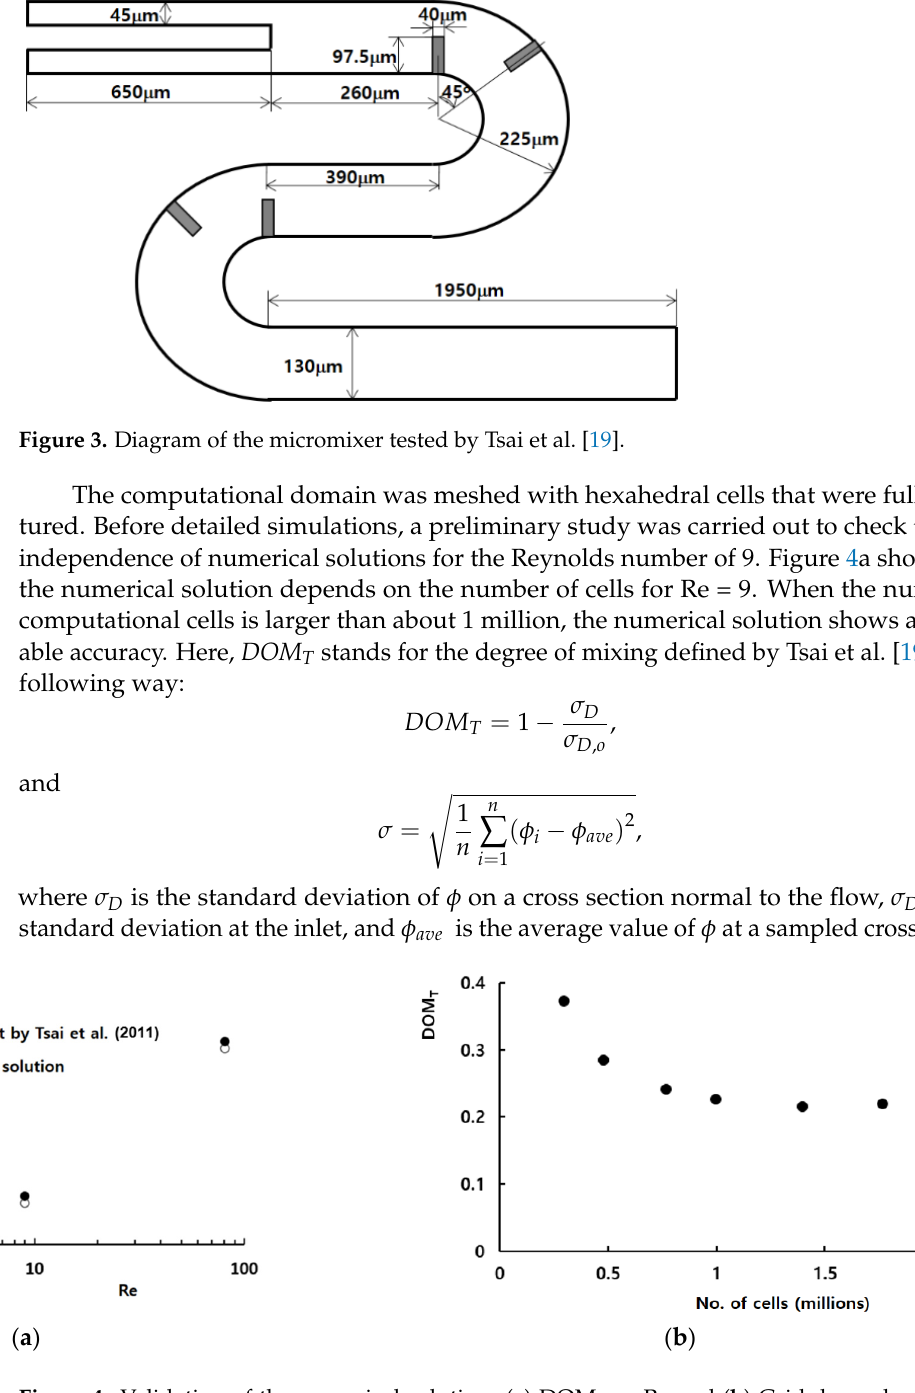
Figure 4. Validation of the numerical solution: ( a ) DOM vs. Re and ( b ) Grid dependence of the nu- merical solution [19].